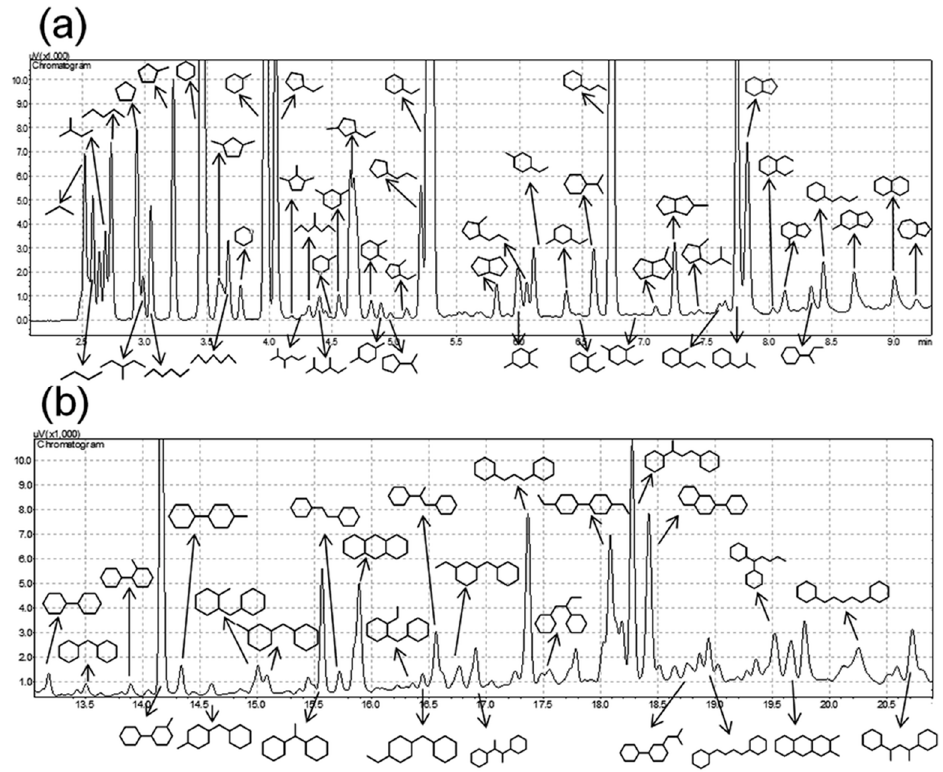
Figure 11. Liquid products of ( a ) C 3 -C 10 and ( b ) C 12 -C 17 hydrocarbons from one-pot lignin conversion over Ni/ASA for ref [64] .